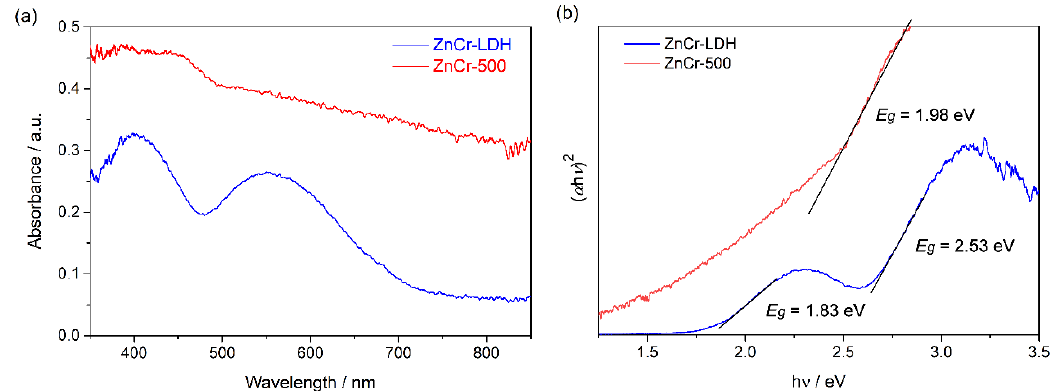
Figure 6. ( a ) UV-Vis absorbance from diffuse reflectance measurements; and ( b ) Tauc plots for ZnCr-LDH and ZnCr-500 photocatalysts.